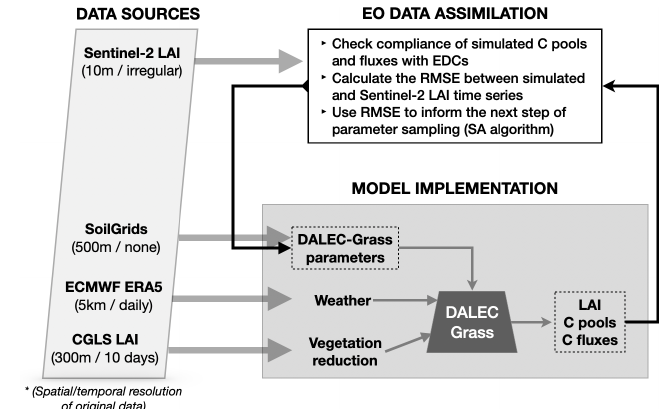
Figure A1. Schematic description of data sources and data flow in the model–data fusion process. The DALEC-Grass model is driven by weekly weather and vegetation reduction data (see Sect. 2.1.5 and 2.1.4). The initial size of the soil organic C (SOC) pool for each simulated field is obtained from the SoilGrids database (Hengl et al., 2017) and used as a DALEC-Grass parameter (with uncertainty attributed to it). DALEC-Grass produces outputs on weekly C pools, fluxes and removals (see Fig. 1). It also produces weekly time series of LAI. Observa- tional time series on LAI are assimilated by reducing the RMSE between observational and simulated LAI time series (see Sect. 2.1.4). The assimilation is performed in CARDAMOM by using the simulated annealing (SA) method/algorithm (see Sect. 2.1.3).